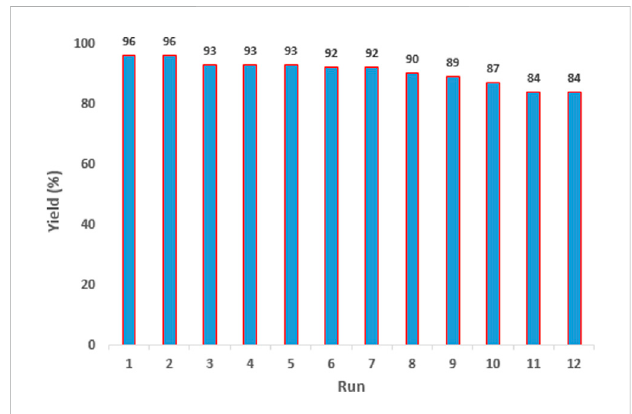
FIGURE 11 The reusability and recoverability of Fe 3 O 4 @PMO/SB-Pd.